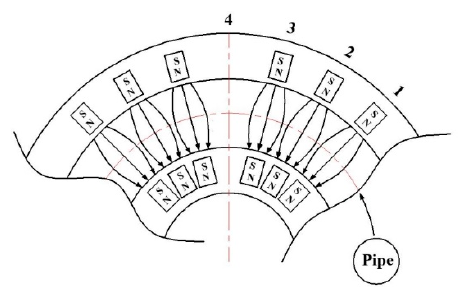
Figure 8. The pipes are moving in a magnetic field cutting magnetic induction lines.